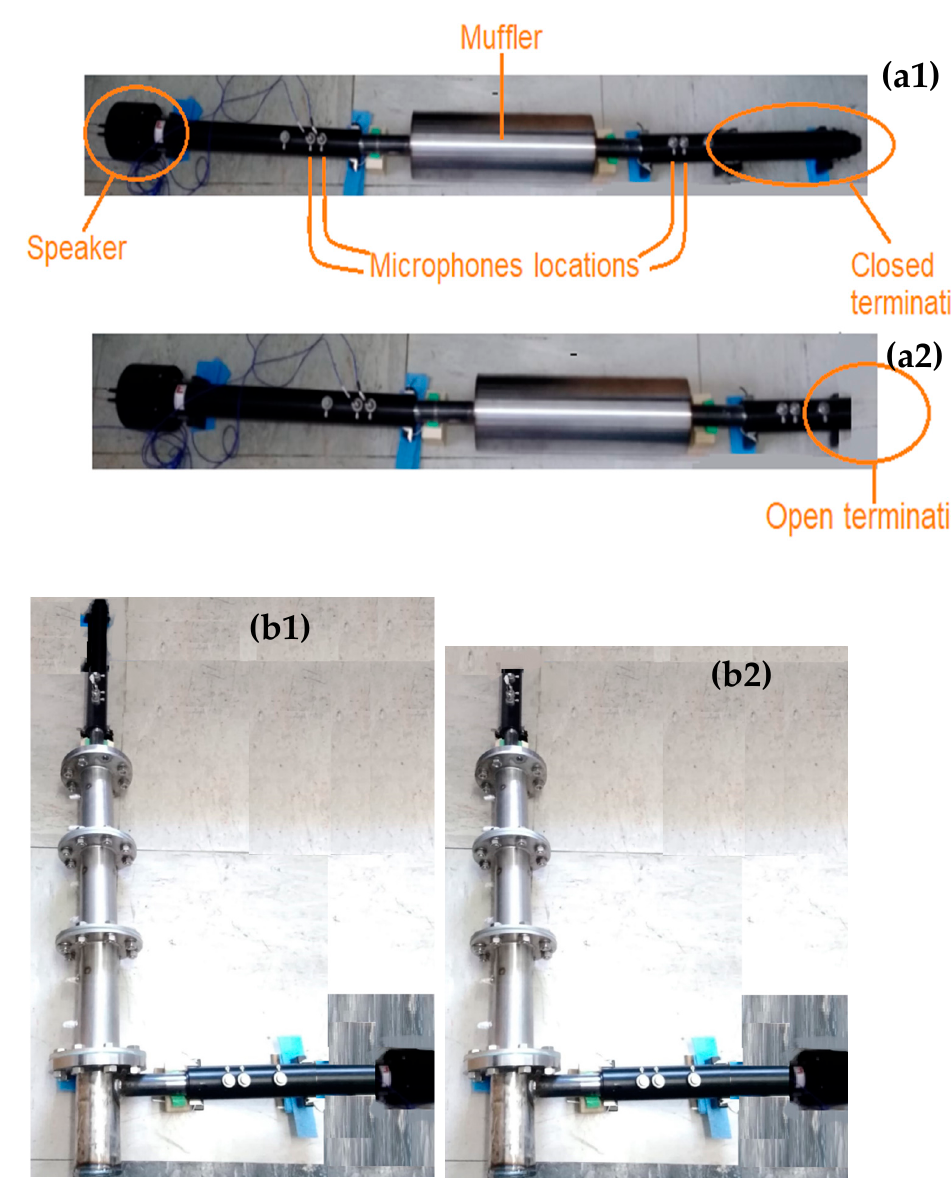
Figure 7. Experimental set-up of the ( a ) expansion chamber and the ( b ) model-scale scrubber with the closed (1) and the open (2) terminations.